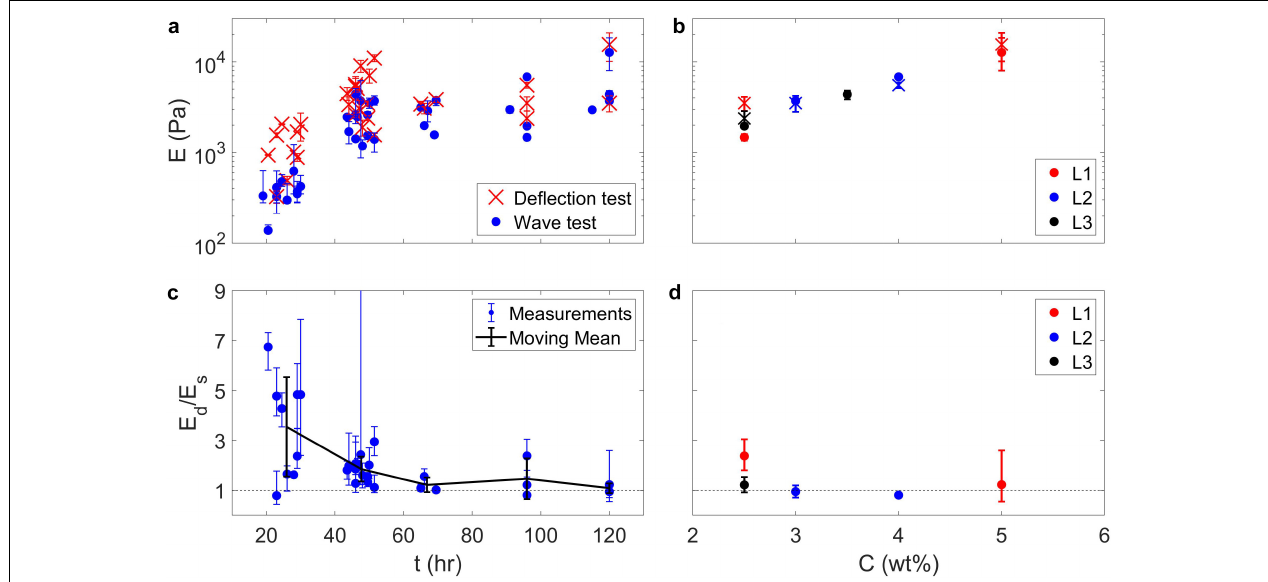
FIGURE 5 | (a) Compiled Young’s modulus measurements, E, from both shear wave (blue · ) and deflection (red × ) measurements, shown against cooling time after placing the gelatin into a cold room refrigerator. (b) Measurements for only the layered gelatins, shown against concentration. Red, blue, and black colors respectively represent experiments L1, L2, and L3. The · and × symbols again represent shear wave and deflection measurements. (c,d) Similar plots, showing the ratio of measurements done by the deflection method to the shear wave method, so that a value of 1 represents a perfect match. Error bars on the individual data points represent the upper bound of one measurement divided by the lower bound of the other, and vice versa. The black line and error bars show the moving mean and standard deviation of these data points. The agreement improves for gelatins that have sufficient time to harden ( > 48 h). Note that adjacent plots share horizontal or vertical